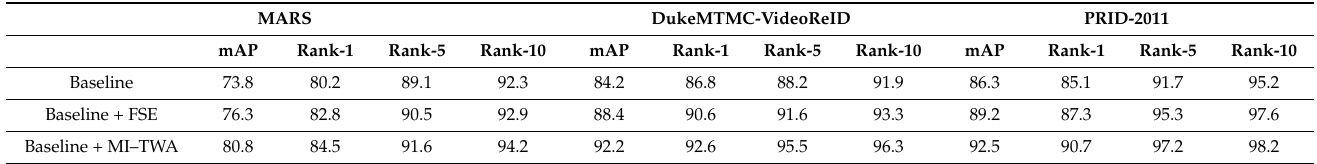
Table 2. Performance comparison of various components in the proposed method. The Rank-i CMC accuracies and mAP scores are